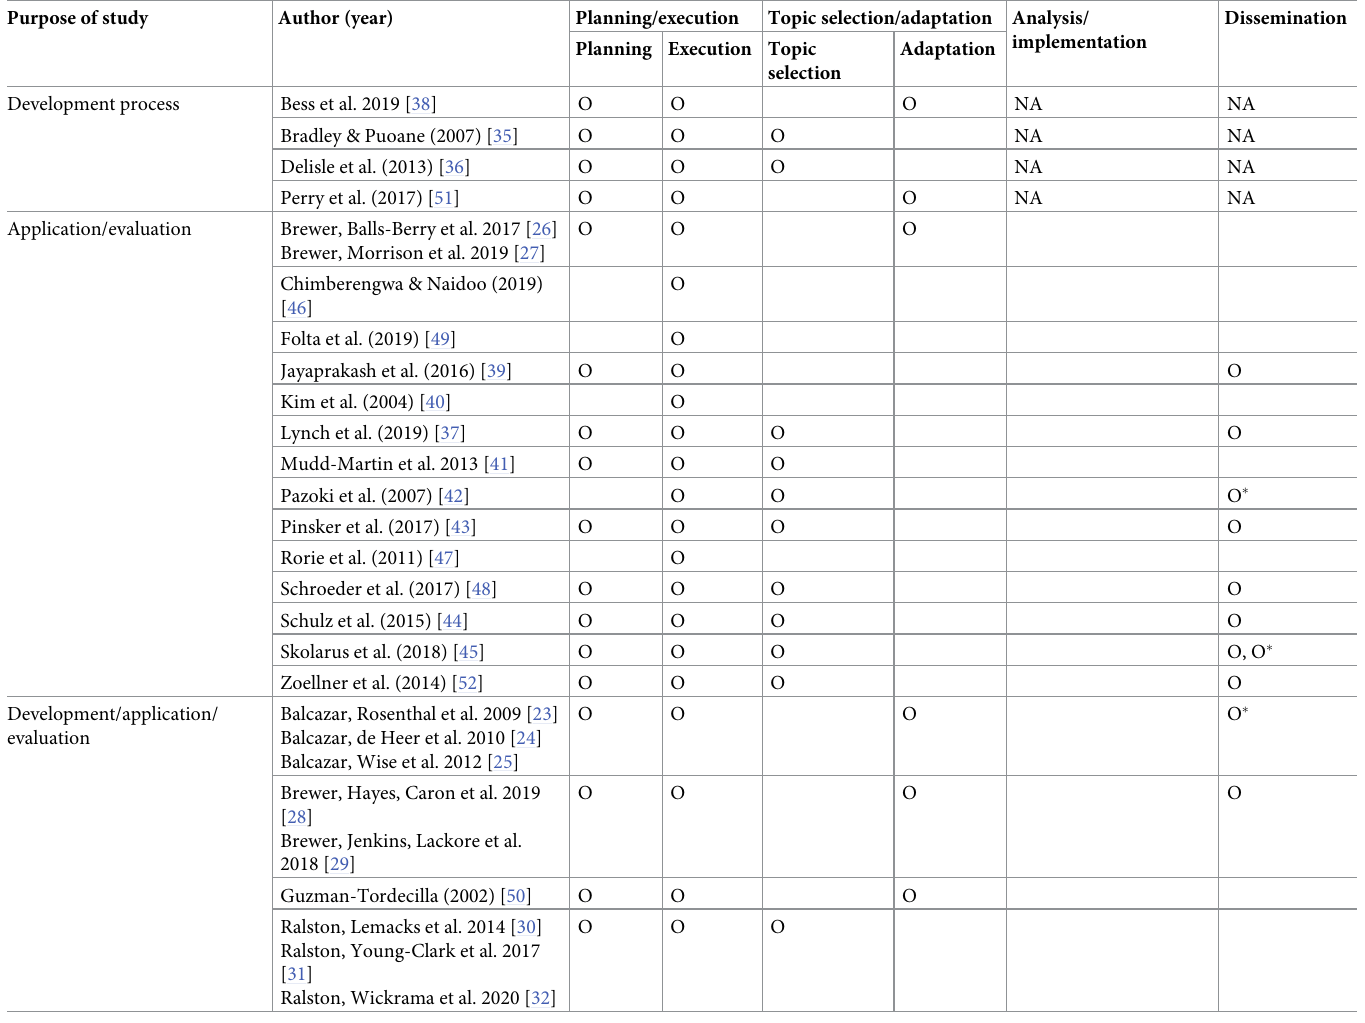
Table 4. Application of CBPR